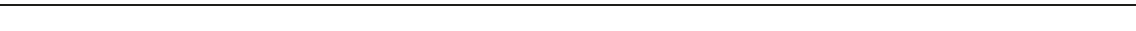
Fig. 4 Pyrimidine biosynthesis is suppressed in the presence of CII low . a Label-free quantitative proteomic analysis of downregulated proteins in SDHB KO MDAMB231 cells and the percentage of proteins identi fi ed per pathway relative to genes with signi fi cantly altered expression in SDHB KO cells. b Scheme of the de novo pyrimidine nucleotide synthesis pathway. c SDS-PAGE following WB analysis of MDA231 sublines for proteins of the de novo pyrimidine pathway. d Densitometric evaluation of the level of the CAD and DHODH proteins by WB. Relative isotopomer amounts (M + 1) of CTP, CDP, UTP, and UDP were assessed by LC-MS/MS using [U- 13 C] glucose ( e ) and [U- 13 C] glutamine ( f ) as tracers. Data shown are mean values ± SD ( n ≥ 3); images are representative of at least three independent experiments. The symbol ** indicates differences with p < 0.05 and ‘ ns ’ indicates non-signi fi cant differences, as assessed by the two-tailed unpaired Student ’ s t